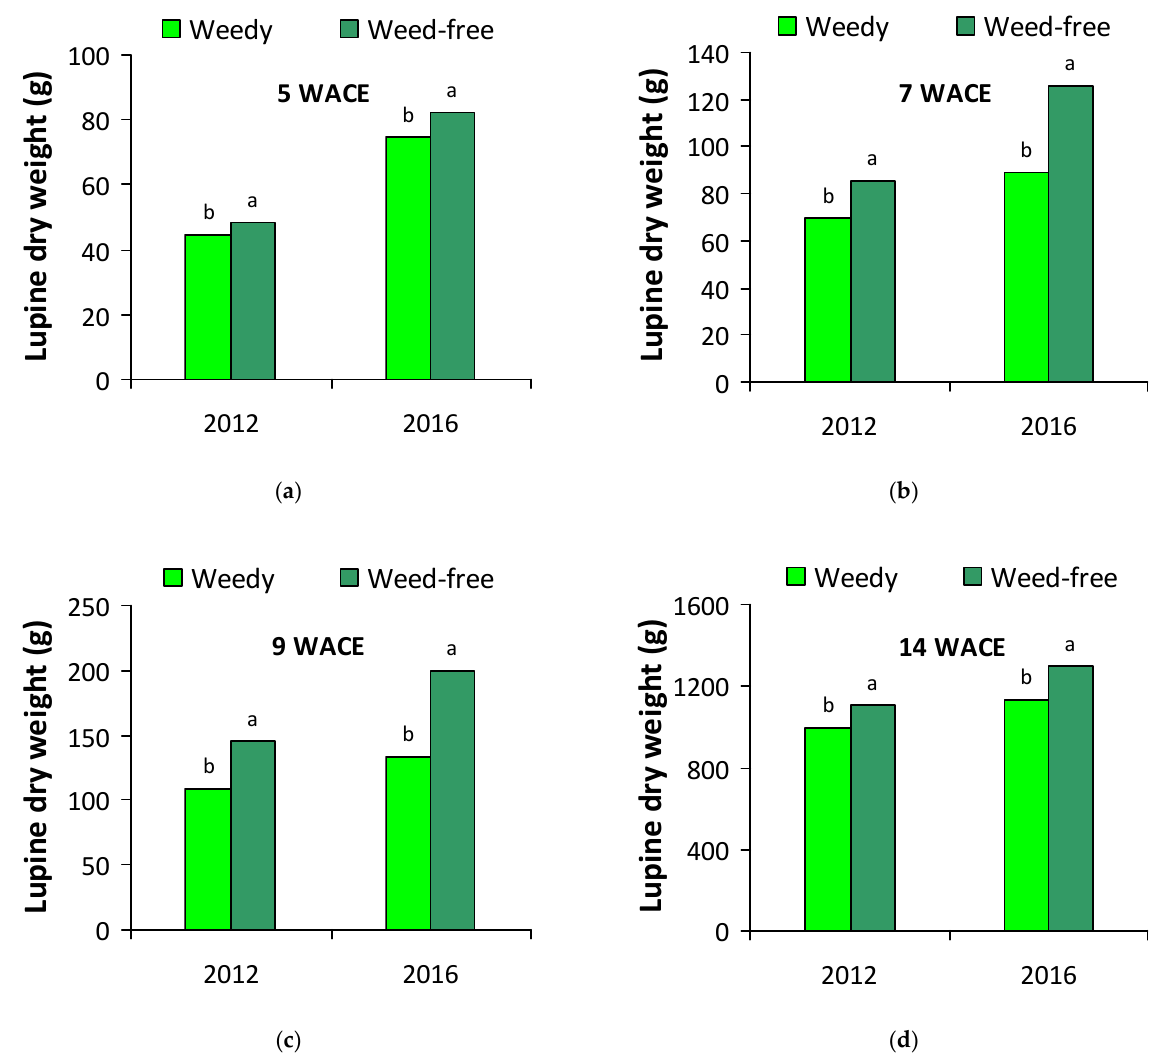
Figure 1. Dry weight of white lupine plants in weedy and weed-free plots ( a ) 5 weeks after crop emergence (WACE); ( b ) 7 WACE; ( c ) 9 WACE; ( d ) 14 WACE in the first and second growing season. Different letters in each growing season within each sub-figure indicate statistically significant differences at p < 0.05.